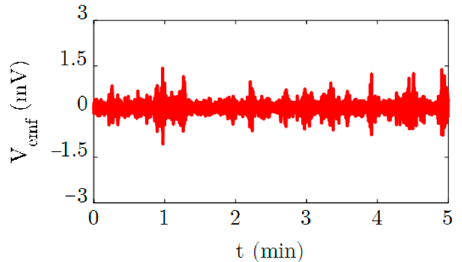
Figure 17. Voltage output from the prototype EMEH subjected to vibration of the bridge.